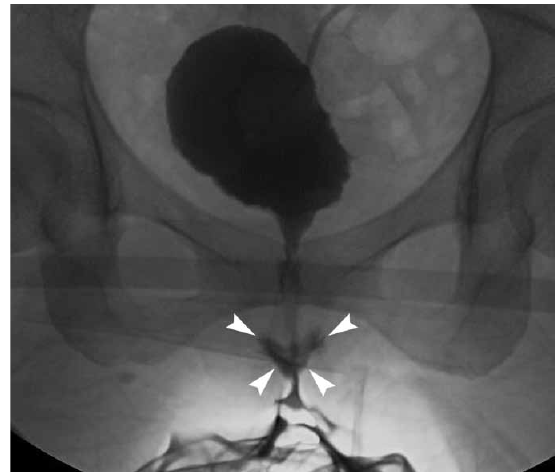
Figure 1 - Voiding cystourethrogram showed contrast material filling the urethral diverticulum (arrowheads) that encircled the urethral